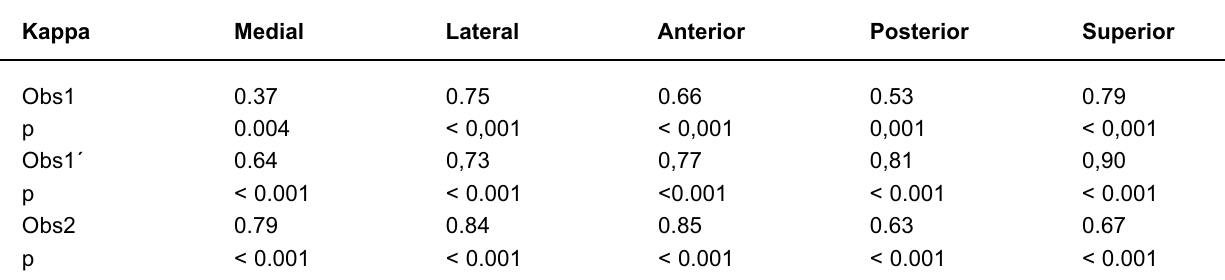
TABLE 2 - Table of parasagittal images in comparison intra-observer, inter-observer with gold standard